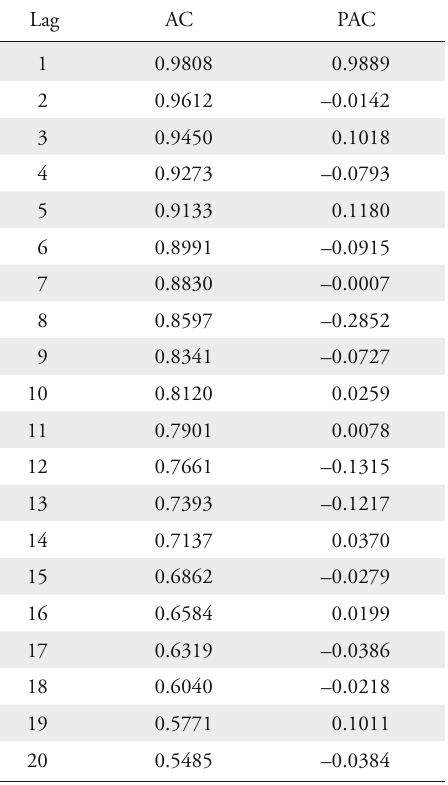
Table 9: Autocorrelation Function (AC) and Partial Autocorrelation Function (PAC) between Switzerland and